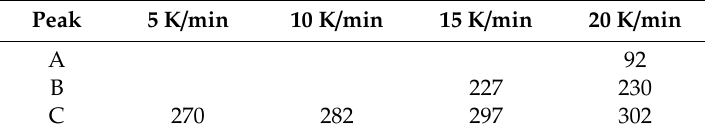
Table 4. Maximum temperatures for individual peaks (in ◦